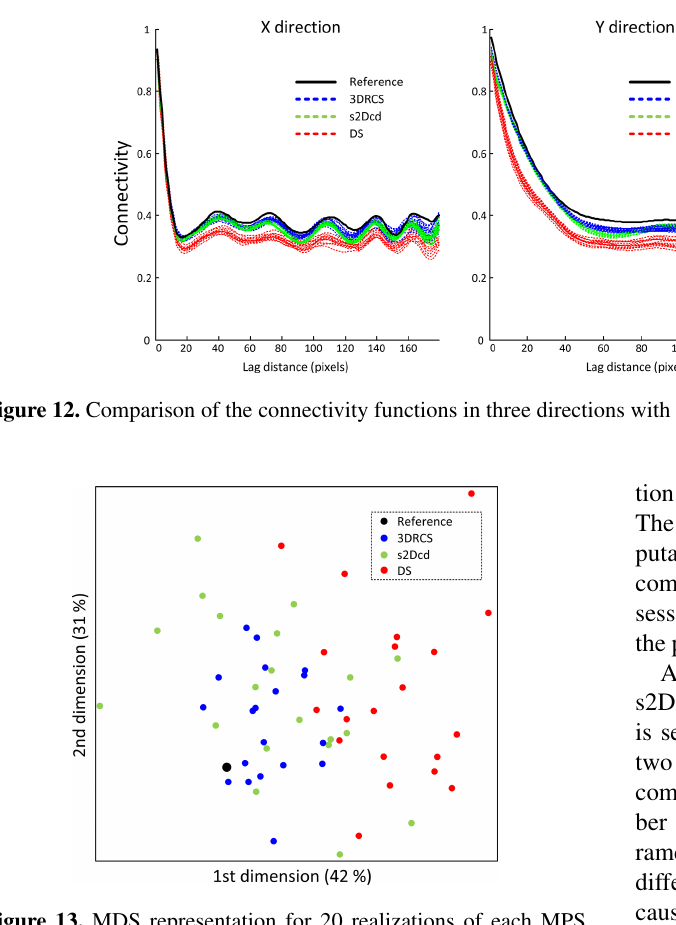
Figure 13. MDS representation for 20 realizations of each MPS